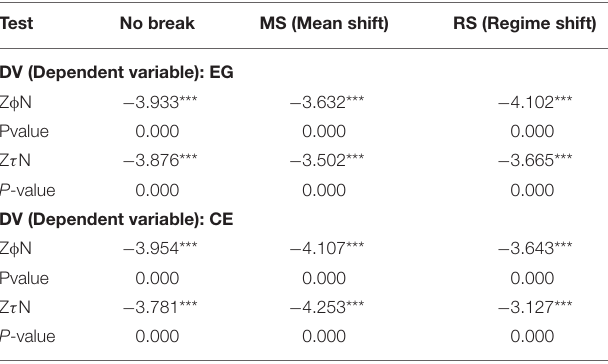
TABLE 5 | Results of panel cointegration